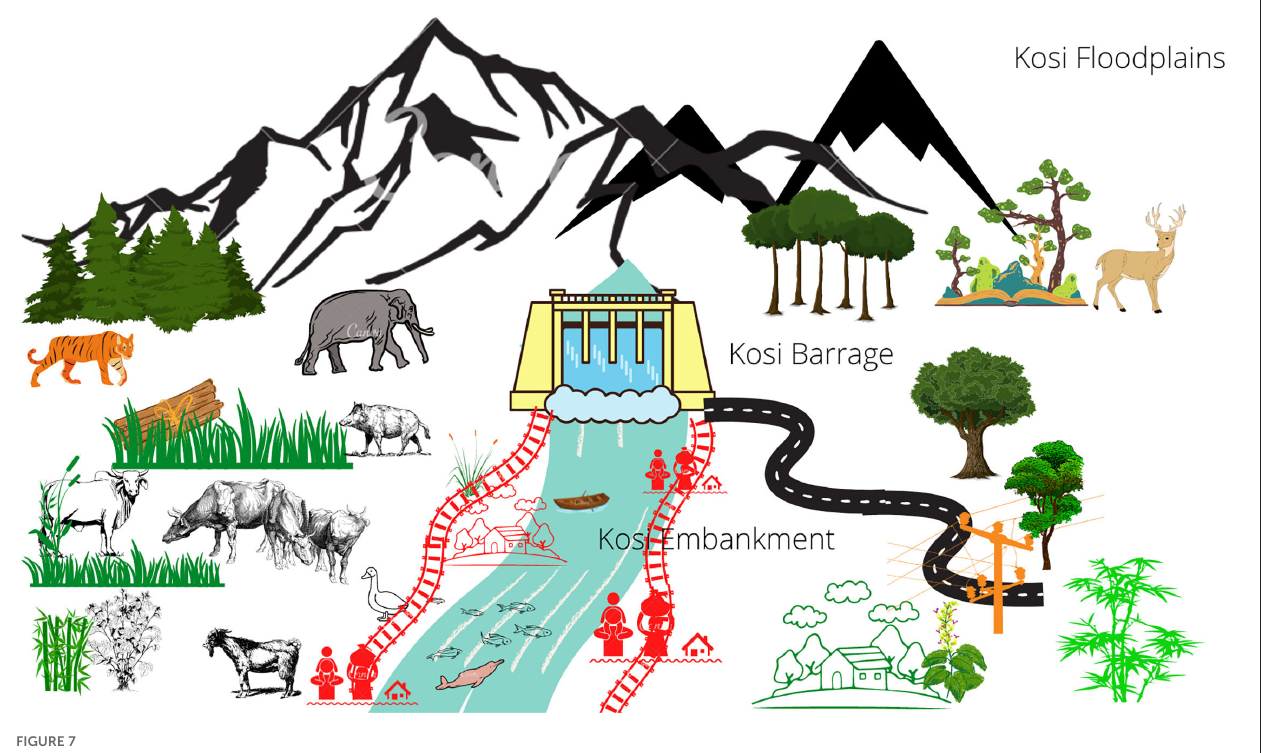
FIGURE7 Illustration of Kosi